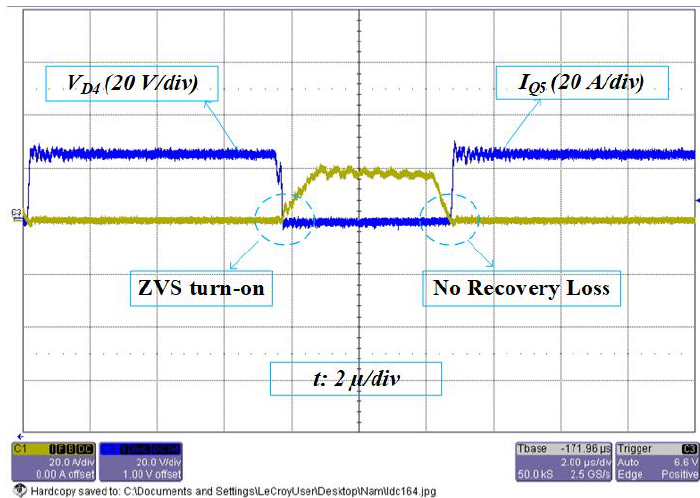
Figure 18. The voltage and current of diode 𝐷 4 at 100% of load.